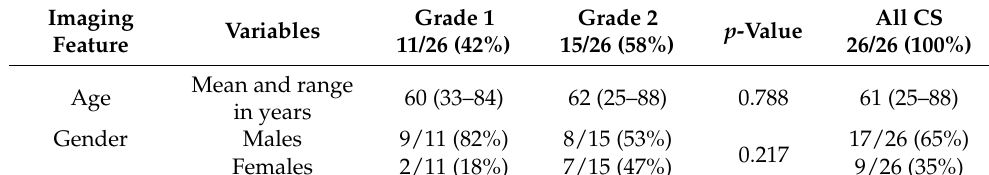
Table 1. Demographics separated by grade.